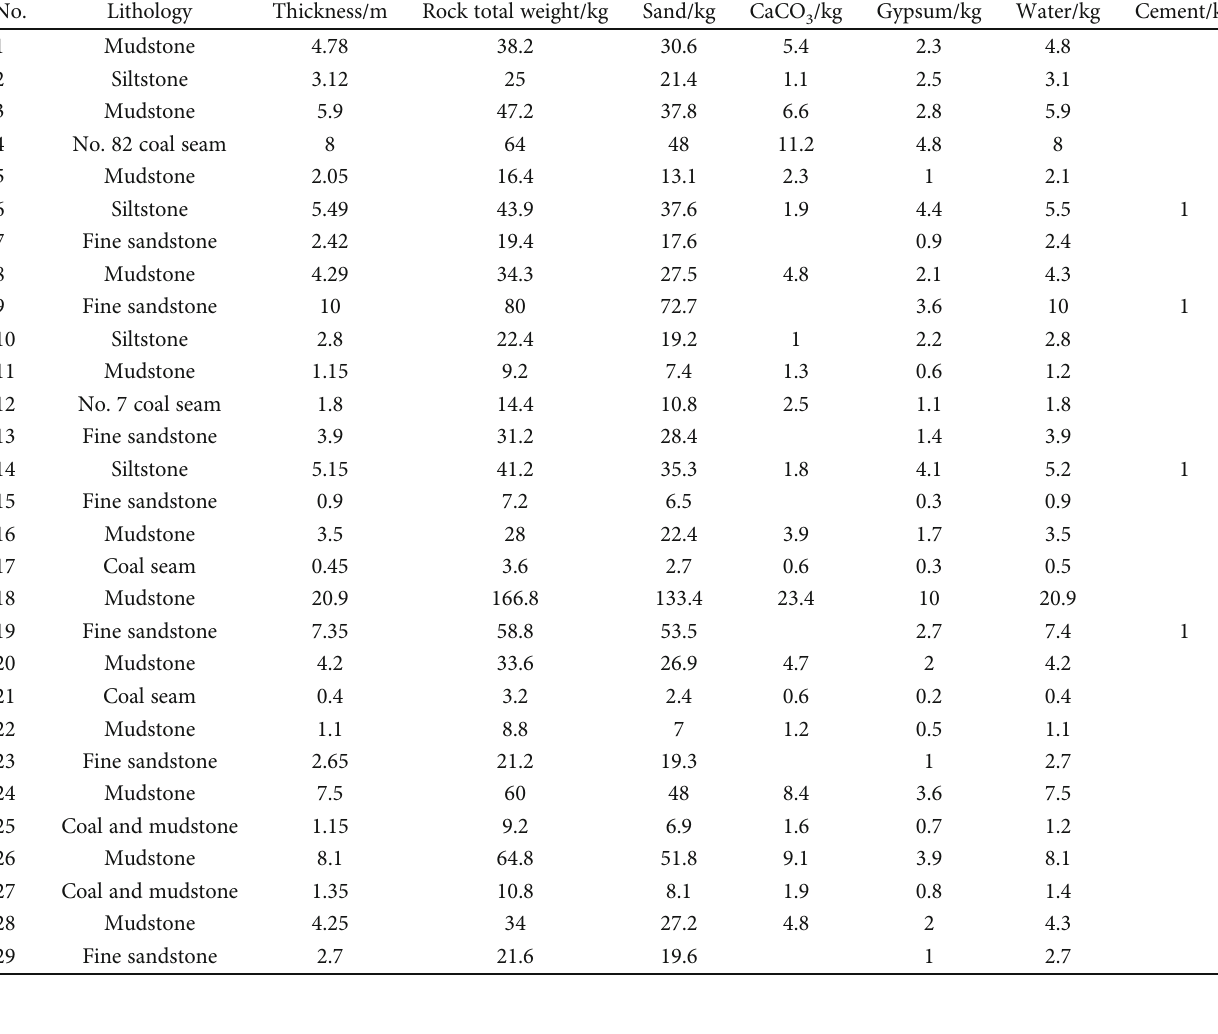
Table 1: The speci fi c parameters of material ratio and laying sequence.